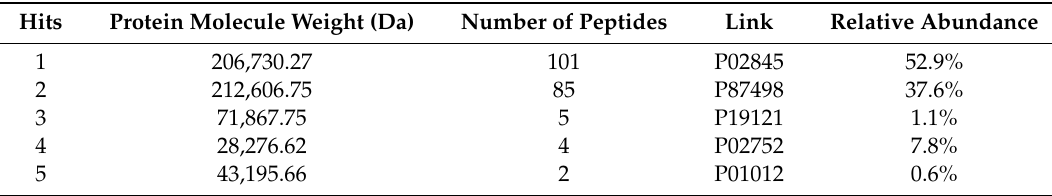
Table 4. The test results of Pv sample by Nano LC-ESI-MS/MS.